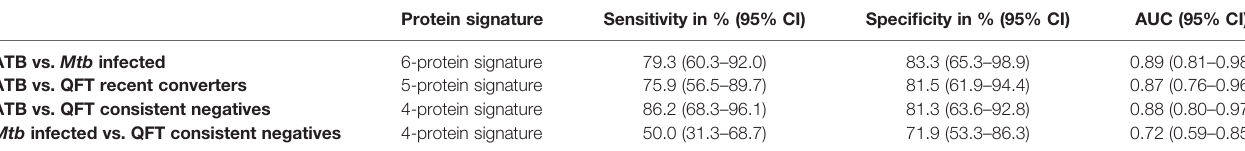
TABLE 2B | Identi fi cation and performance of protein signature.